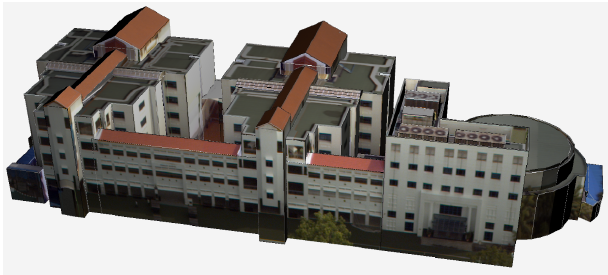
Figure 6. A complete building model to derive the maximum number of